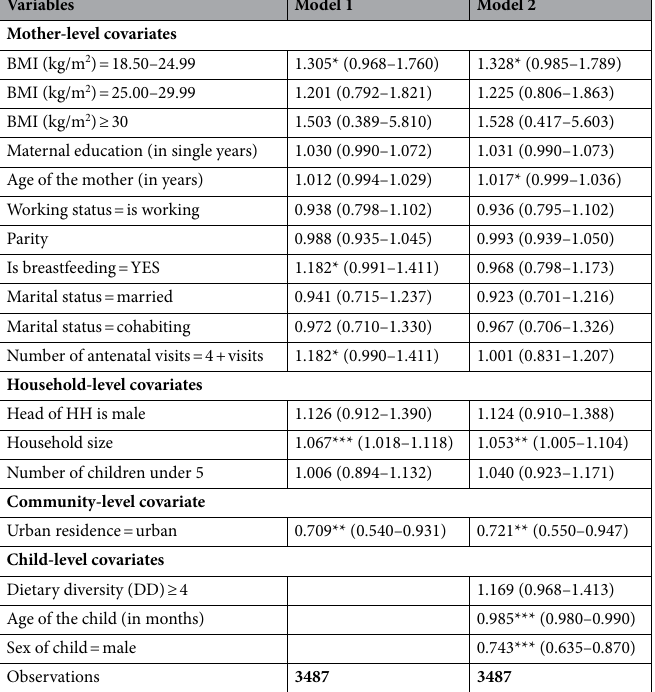
Table 5. Multivariable analysis of the effects of socio-demographic factors on better linear growth/non- stunting among children living in poor households in Mozambique. Significant values are in bold.